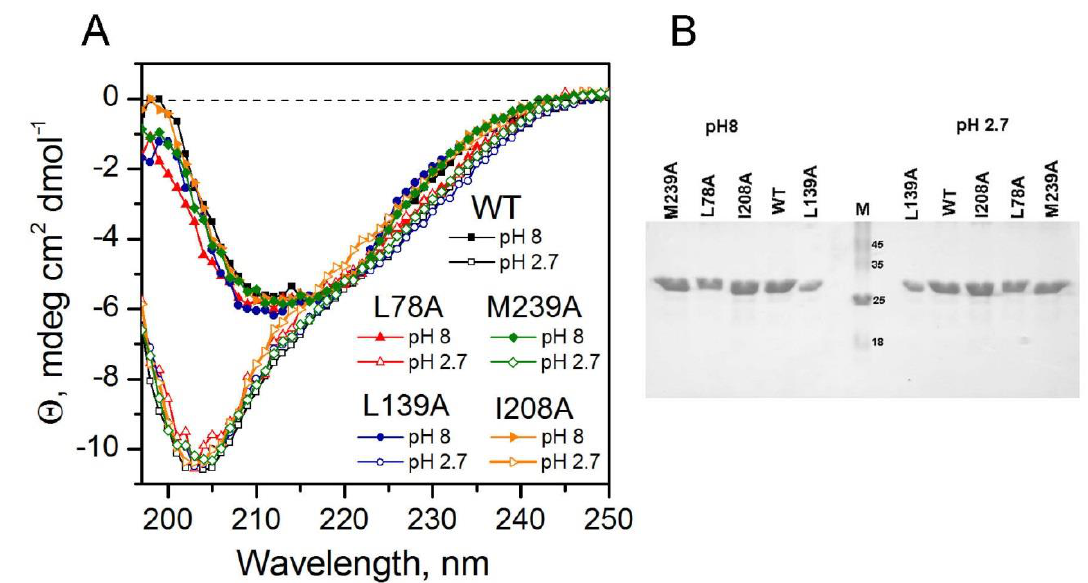
Figure 8. ( A ) CD spectra samples of carbonic anhydrase: wild-type (black), L78A (red), L139A (blue), I208A (orange), M239A (green) before incubation at pH8 (filled characters) and pH 2.7 (empty characters), 20 °C. ( B ) SDS-PAGE electrophoregrams of the same samples before incubation at 57 °C. M — molecular weight markers.